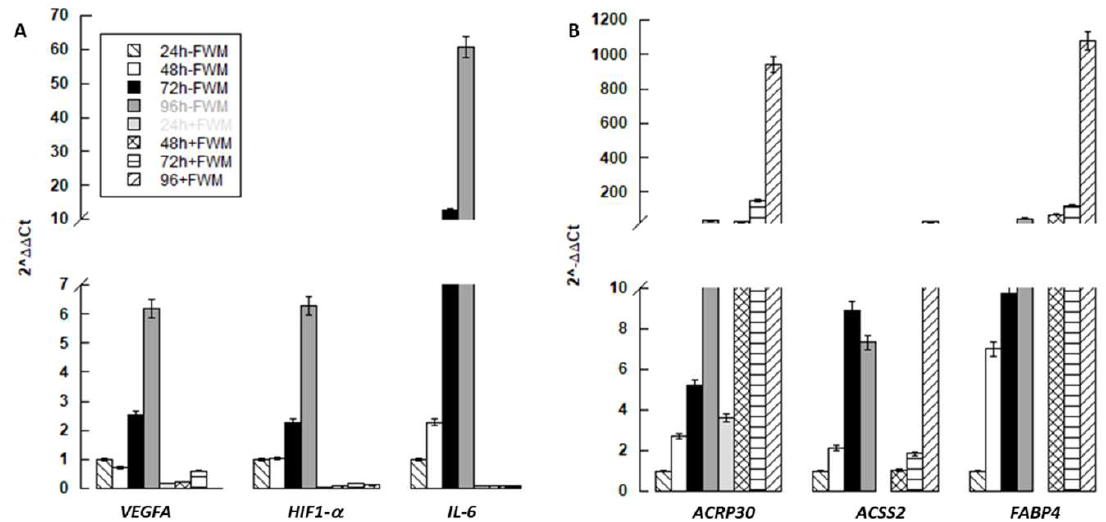
Figure 5. mRNA expression of markers related to angiogenesis ( A ) and differentiation ( B ) of hASCs grown in presence ( + FWM) or not ( − FWM) of FWM ( n = 3).